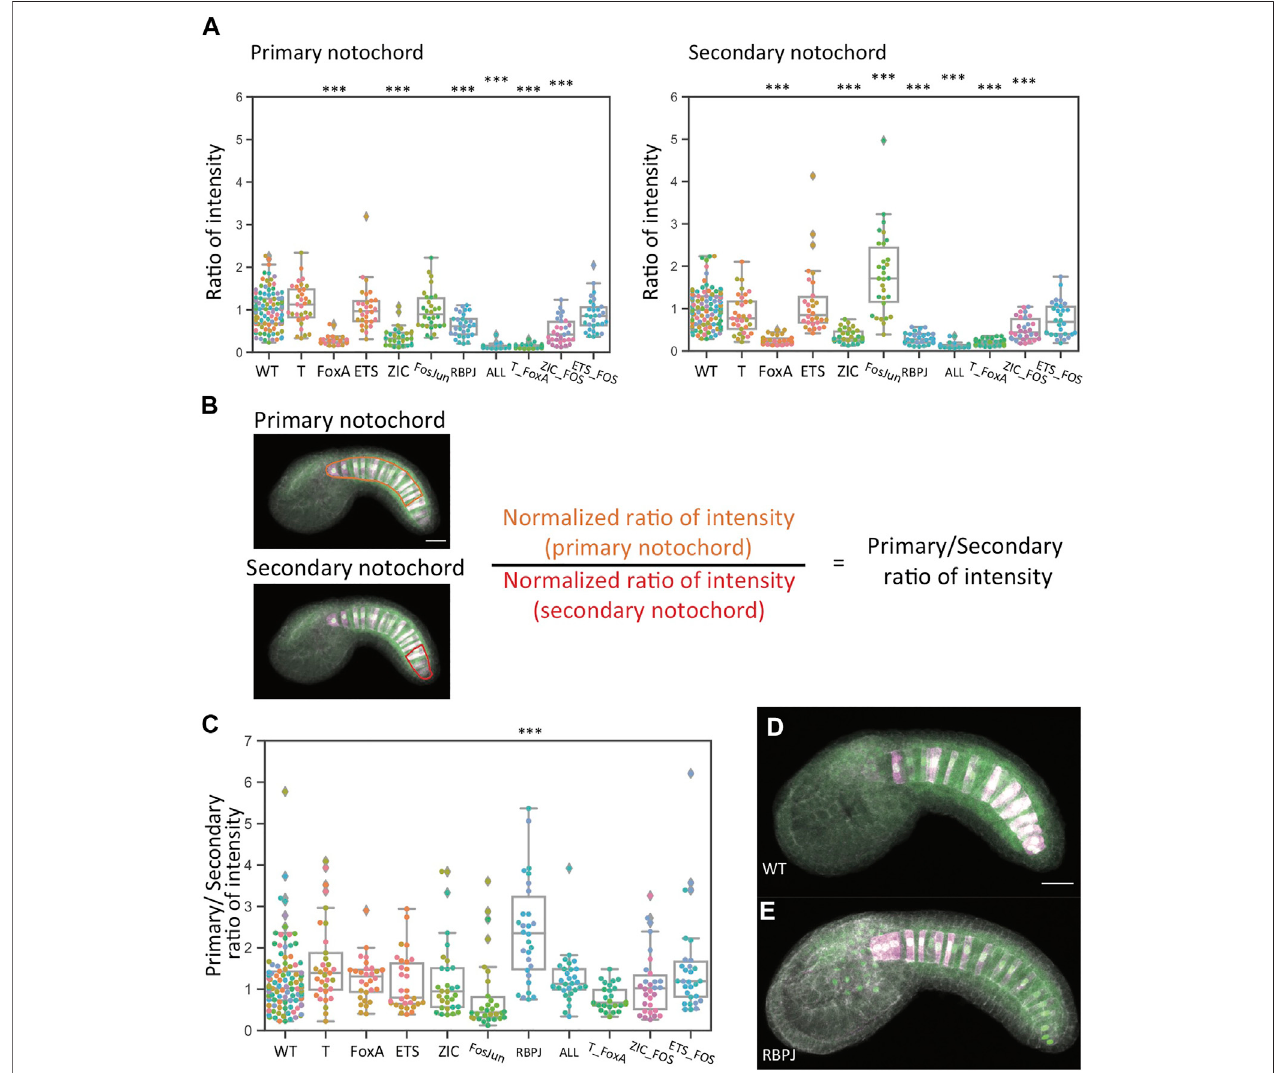
FIGURE 5 | Analysis of reporter expression in primary versus secondary notochord. (A) Left: normalized reporter expression in primary notochord. Right: normalized reporter expression in secondary notochord. Asterisks indicate differential reporter expression between the mutant construct and the wildtype construct. *** p < 0.001. (B) Schematic indicating how the primary/secondary normalized expression ratio was calculated. (C) The ratio of normalized primary notochord reporter expressiontonormalizedsecondarynotochordreporterexpression.Asterisksindicateadifferentialprimary/secondaryratiobetweenthemutantconstructandthe wildtype construct. *** p < 0.001. ** p < 0.01. * p < 0.05. (D,E) Representative sum-projected confocal images. (D) : wild type. (E) : RBPJ. Magenta: YFP reporter expression. Green: Bra > H2B: HA internal control expression. Gray: phalloidin. Scale bar, 20